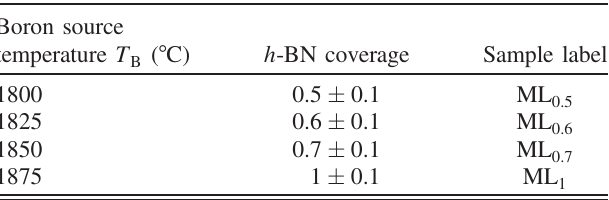
TABLE I. Boron source temperature T coverage, and sample label for our set of atomically thin h -BN layers grown epitaxially on graphite, shown in Fig.